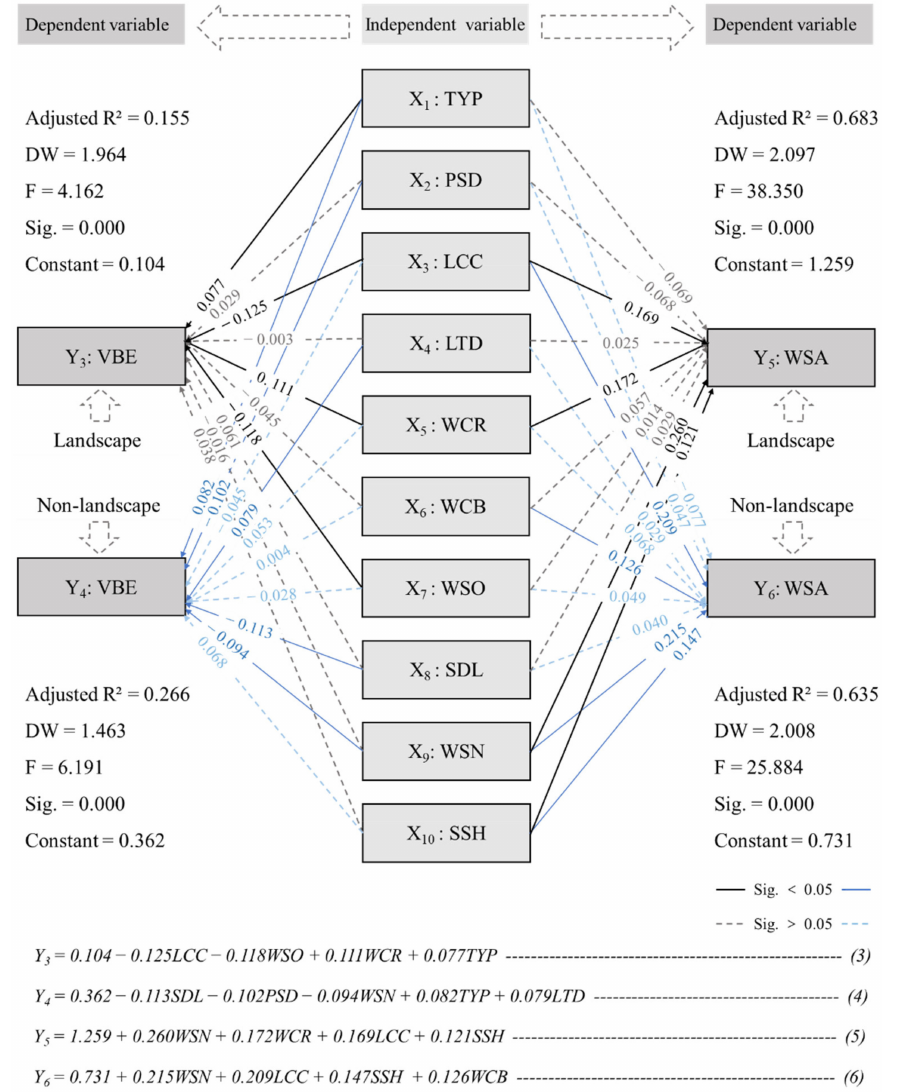
Figure 8. Spatial perception factors that influence the visual behavior and satisfaction preferences of participants in different professional backgrounds in the forest recreation landscape space. Note: TYP: forest recreation landscape spatial type; PSD: whether the plant species are diverse; LCC: whether the landscape content is changing; LTD: whether the near-middle landscape is three-dimensional; WCR: whether the color is rich; WCB: whether the color is bright; WSO: whether the space is open; SDL: can you see the distant landscape; WSN: whether the space is neat; SSH: whether the space has a sense of hierarchy; VBE: the evaluation of visual behavior; WSA: Whether you are satisfied with it. This figure was created by Yu Gao (Shenyang Agricultural